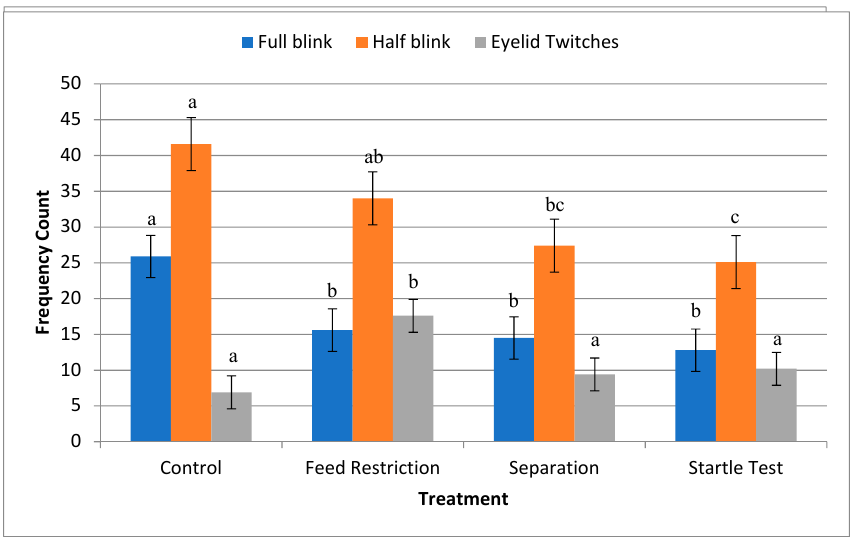
Figure 2. Total number of observations of full eye blinks, half blinks and eyelid twitches (±SD) in horses ( n = 33) over a 3 min observation period during control, feed restriction, separation from conspecifics or a startle test. a,b,c differ across treatments p < 0.0001. Horse heart rate was higher during feed restriction (44 ± 13 beats per minute (bpm)) and lower during separation (37 ± 7 bpm) and the startle test (37 ± 8 bpm) compared to the control (39 ± 8 bpm) (F(3,92) = 306.12, p < 0.0001). There was no effect of facility ( p > 0.05) on the behaviours or HR. The horses’ right ear was forward more often during separation and the startle test (F(3,95) = 8.29, p < 0.0001; Figure 3), whereas it was more often sideways during feed restriction and the control (F(3,95) = 22.53, p < 0.0001). There was no difference among treatments for the percentage of time the horses had their ears back (F(3,95) = 0.82, p > 0.49).